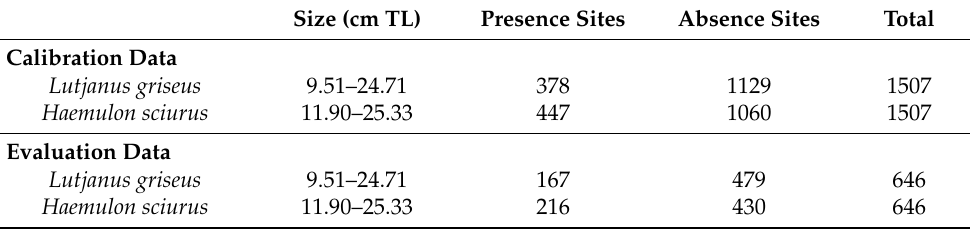
Table 2. Sub-adult gray snapper ( Lutjanus griseus ) and bluestriped grunt ( Haemulon sciurus ) occur- rence records in the southern Florida study area. Prior to habitat suitability modeling, data were randomly partitioned into calibration (70%) and evaluation (30%)